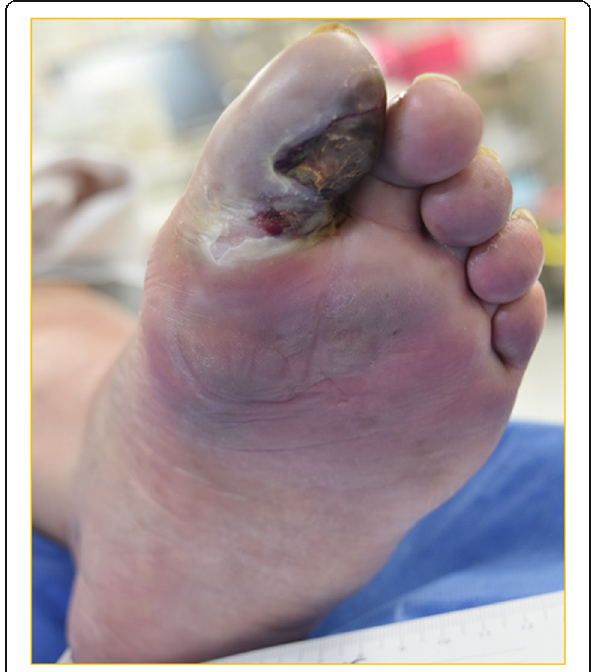
Fig. 1 The picture on admission showed that the left foot was swollen red, and the first toe was gangrenous